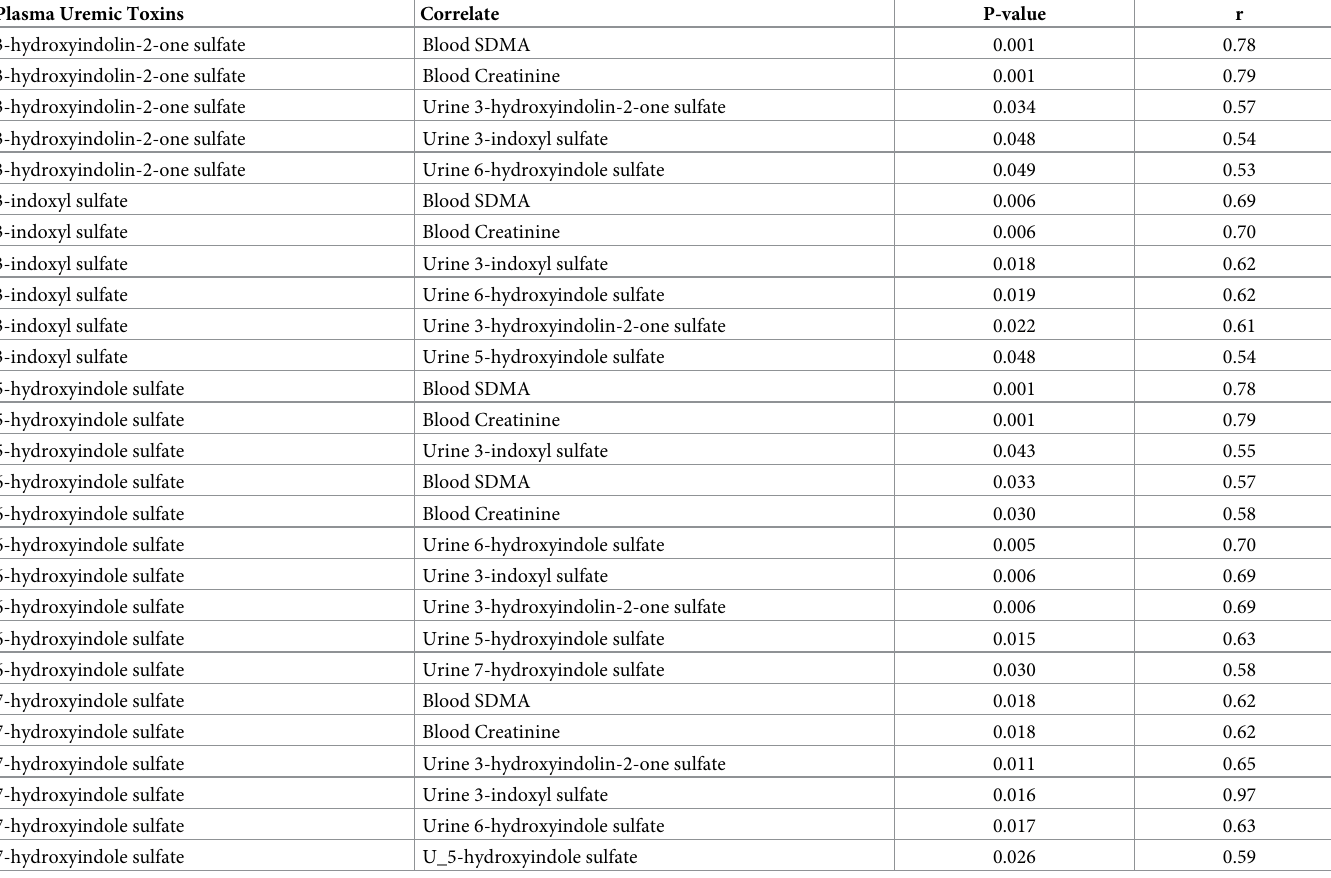
Table 7. Significant ( P � 0.05) correlations for plasma uremic toxins and plasma kidney biomarkers and urine uremic toxins in cats (N = 7) with Chronic Kidney Disease (CKD) after feeding control food or test food for 8 weeks in a crossover feeding